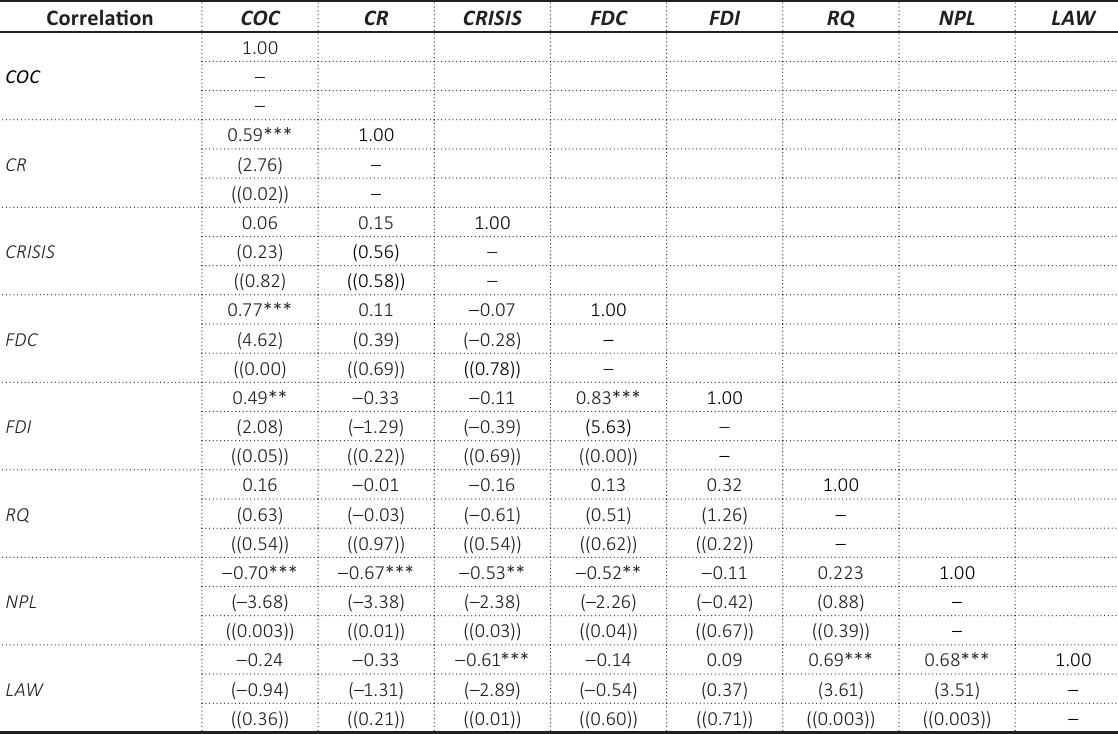
Table 4. Pearson correlation for institutional variables